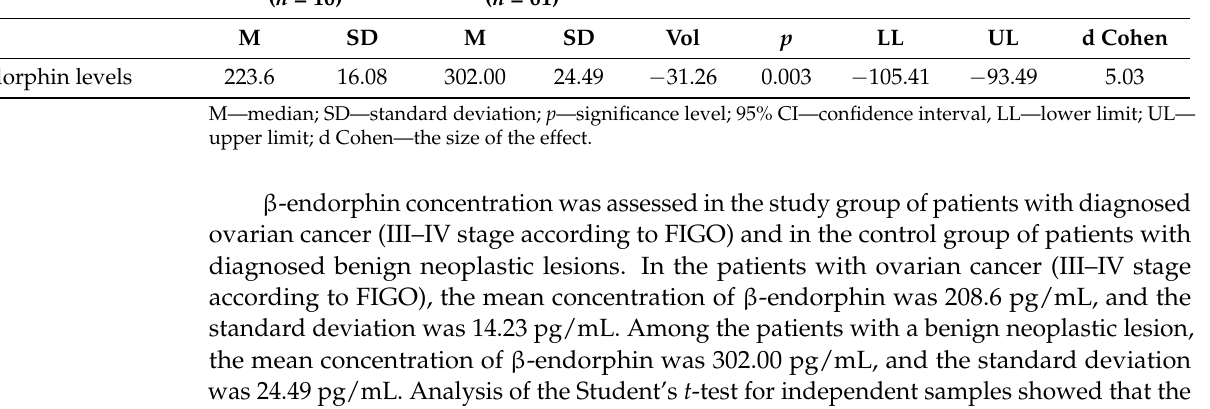
Table 2. The preoperative levels of β -endorphin in the study group (with ovarian cancer—I–II stage according to FIGO) and the control group (with benign neoplastic lesions and simple ovarian cysts). FIGO